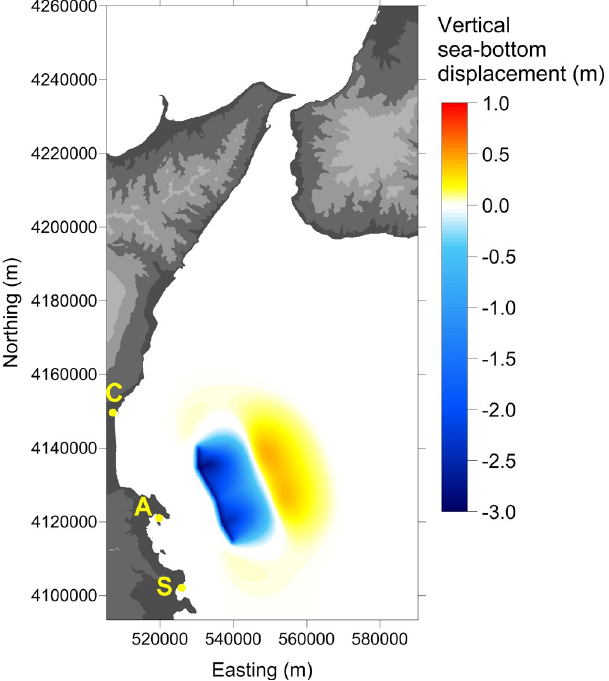
Fig. 5. Vertical coseismic sea-bottom displacement, coinciding with the initial sea surface displacement, computed for the main active extensional fault. “C”, “A” and “S” indicate the position of Catania, Augusta and Siracusa,